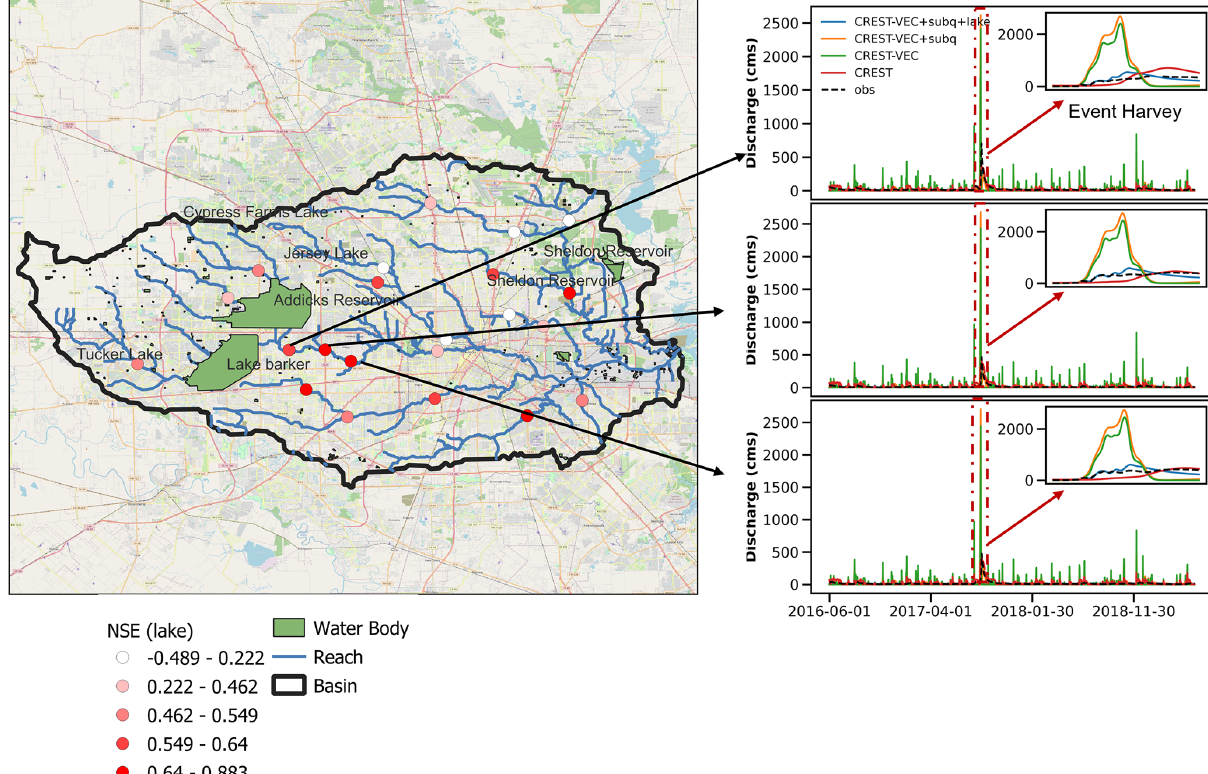
Figure 4. Performance of models downstream of two lakes. The Nash–Sutcliffe efficiency coefficients are obtained from the CREST-VEC model with lake routing and subsurface routing. Three plots of time series of stream gauges (from upstream to downstream: 08073500, 08073600, 08074000) are pointed to beside the map, and the Hurricane Harvey event is highlighted in the red box and insets. Base map copyright © Google